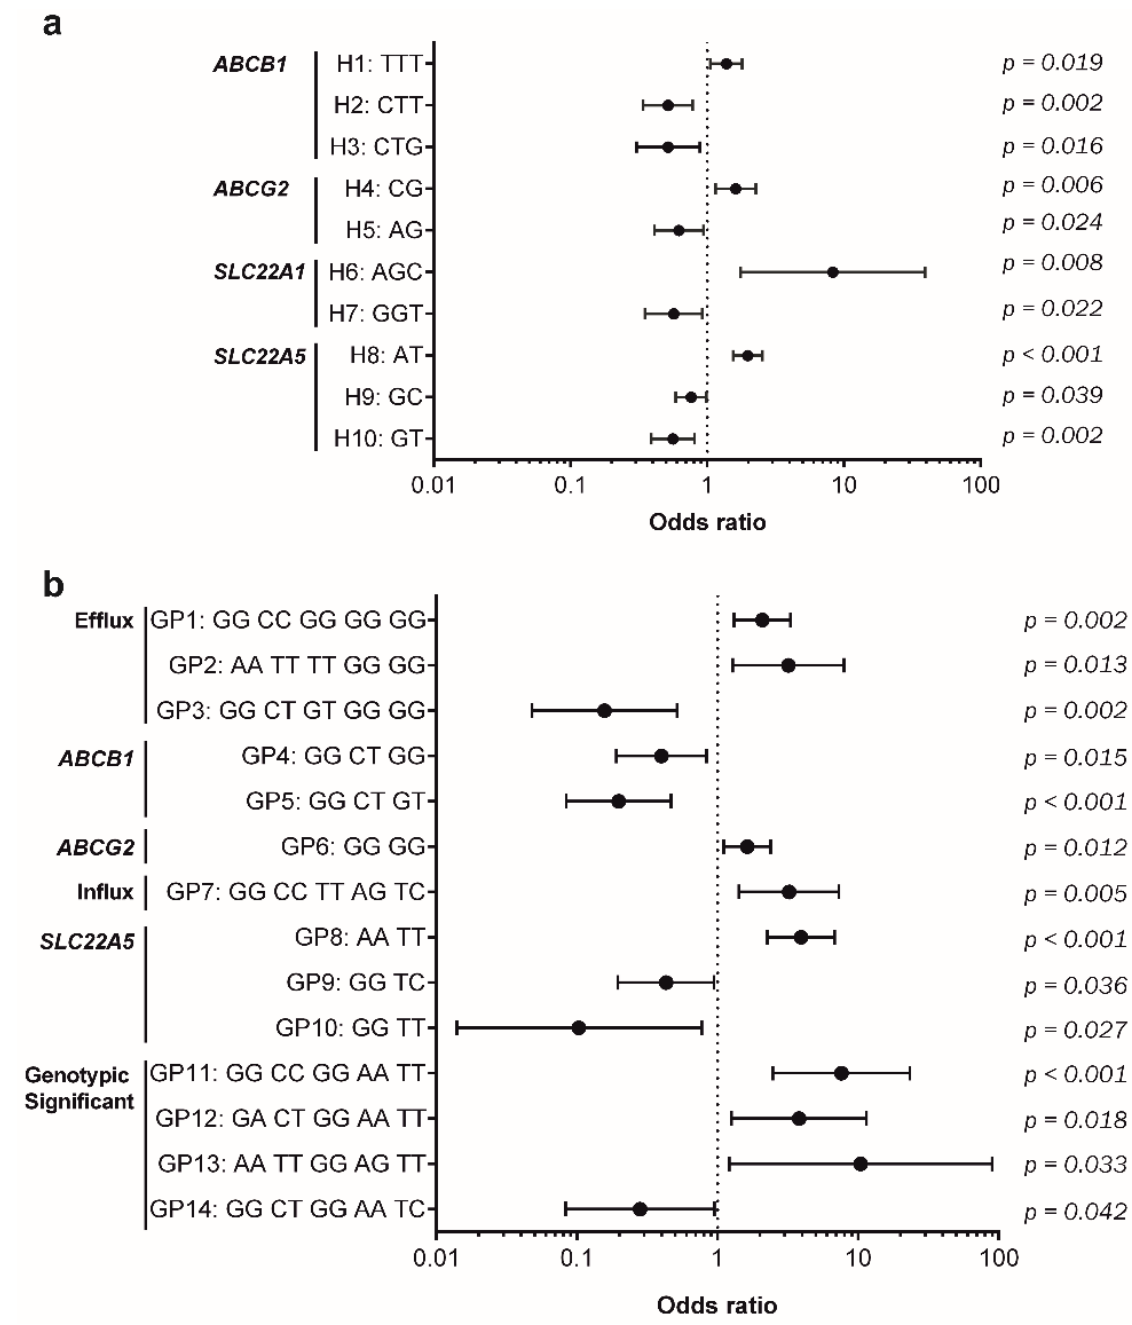
Figure 1. Haplotypes (H) and genotypic profiles (GP) significantly correlated with CML development; ( a ) the haplotypes and ( b ) the GPs positively correlated with CML susceptibility. The respective p value is shown for each analysis. Haplotype groups: ABCB1 : rs1045642/rs1128503/rs2032582;